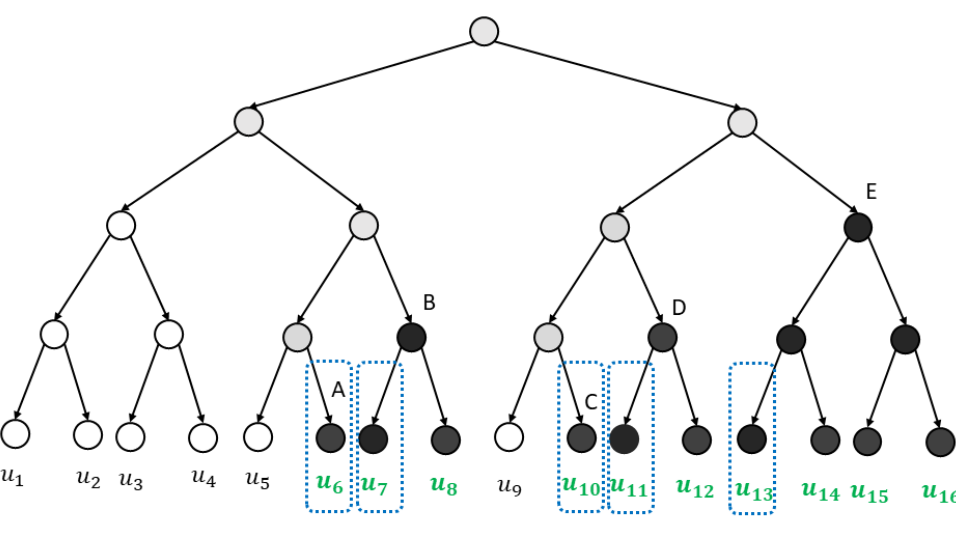
Figure 2. Rate-1 node presentation through SC binary tree for polar codes at N = 16 and K =